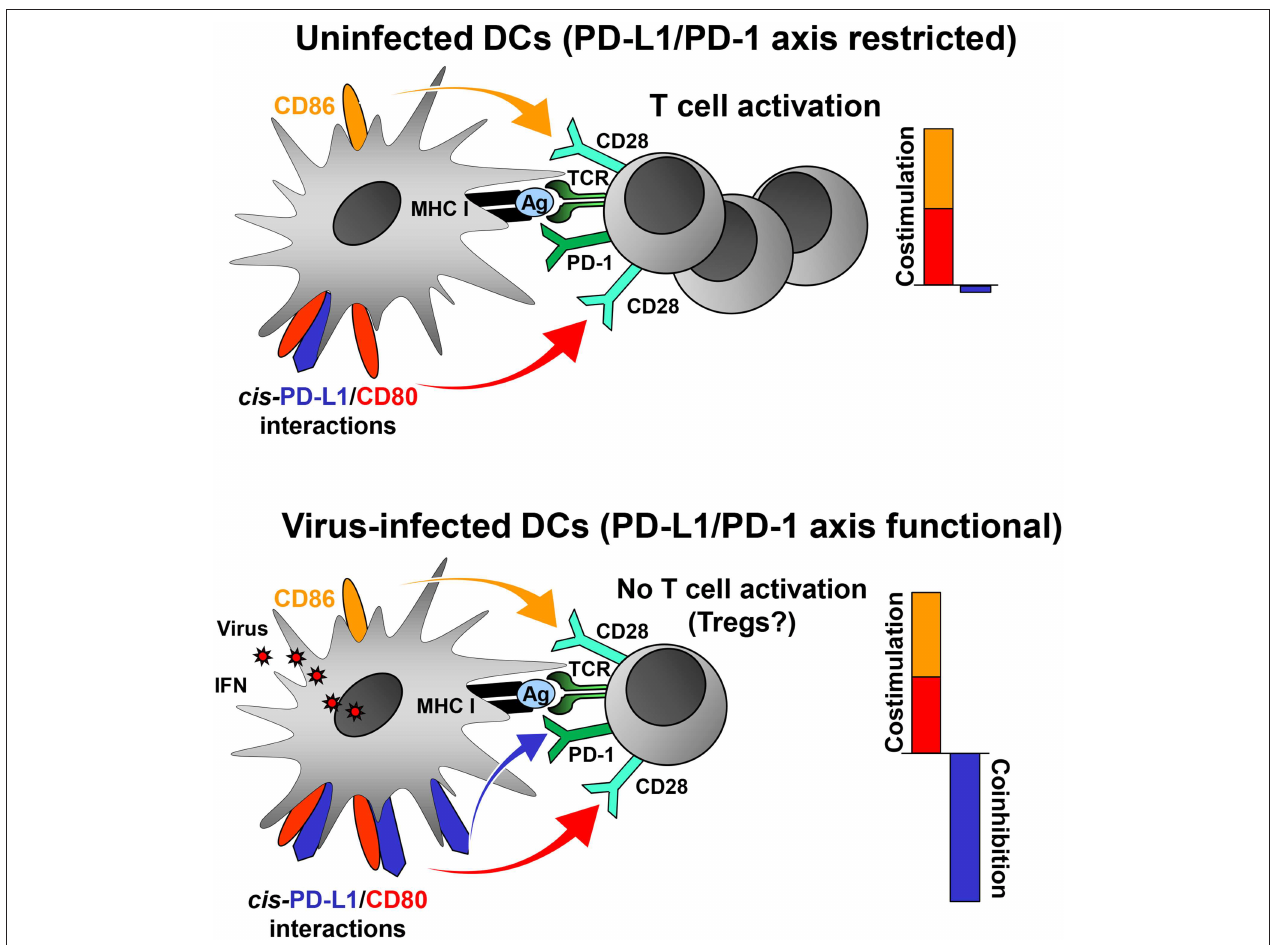
FIGURE 1 | PD-L1 mediated viral regulation of T cell activation. Upper graph: In the absence of viral infection mature dendritic cells (DCs) express relatively low levels of PD-L1. Recognition of cognate antigen (Ag) bound to MHC class I molecules by T cell receptor (TCR) results in upregulation of PD-1 on T cells. DCs express co-stimulatory molecules CD80 and CD86 allowing efficient co-stimulation of T cells via CD28. The PD-1/PD-L1 axis is not co-inhibitory due to restriction by cis -PD-L1/CD80 interactions, and thus T cells are activated. Lower graph: In the context of viral infection DCs upregulate PD-L1 due to exposure to viral PAMPs and high levels of type I IFN. The restricting cis -PD-L1/CD80 interactions are most likely overwhelmed by virus-induced PD-L1 resulting in PD-1 signaling and prevention of T cell activation. The consequences of this for the generation of Tregs is as of yet